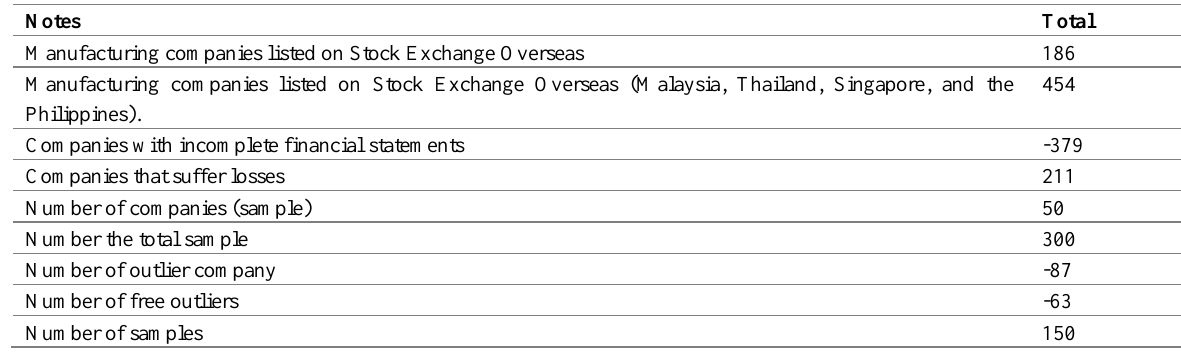
Table 2: Results of Sample Selection